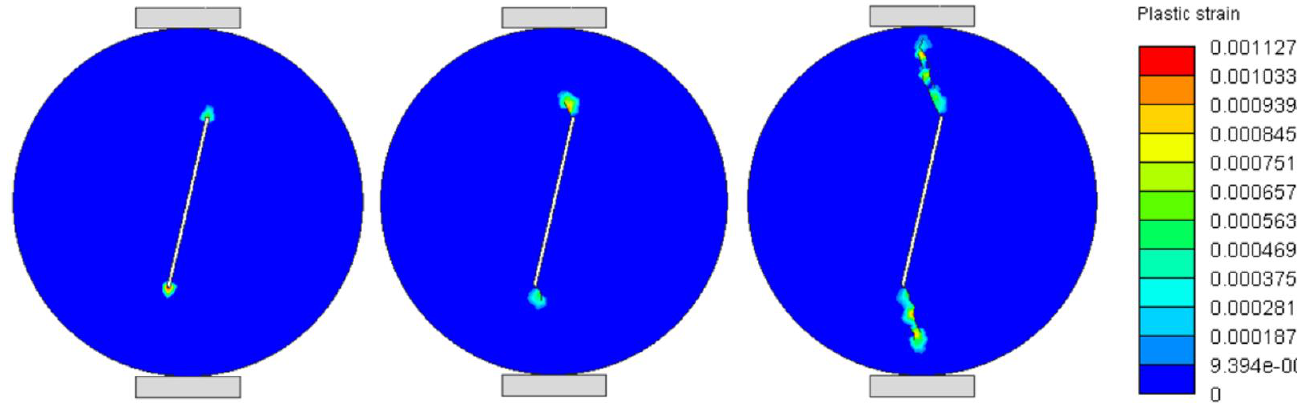
Figure 18. Plastic strain evolution for Brazilian disc with a crack of 15° angle.